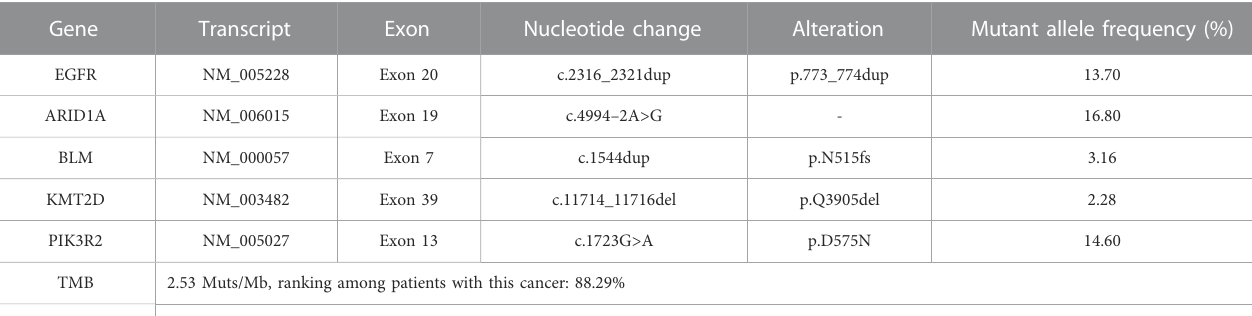
TABLE 1 Somatic variations in the